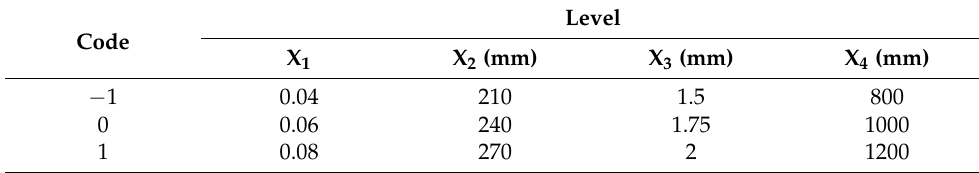
Table 2. Levels and codes of factors in BBD.